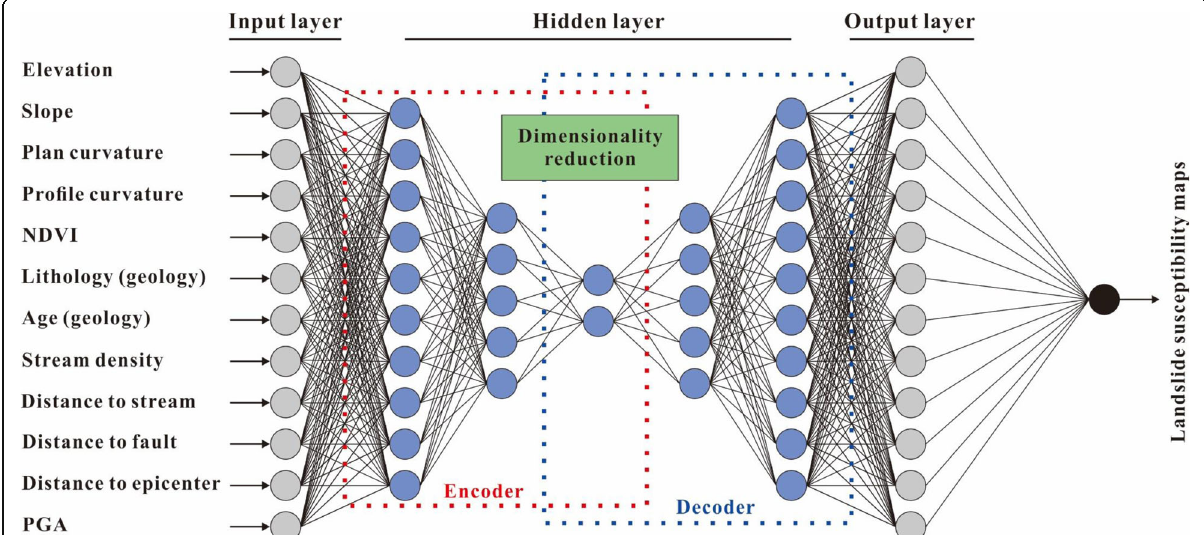
Fig. 4 Architecture of autoencoder based on deep neural network with five hidden layers used in this